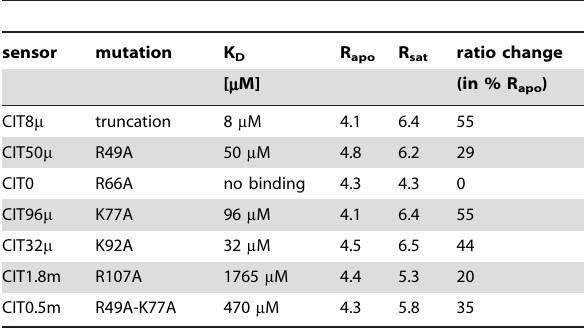
Table 1. Binding properties of seven citrate sensors.